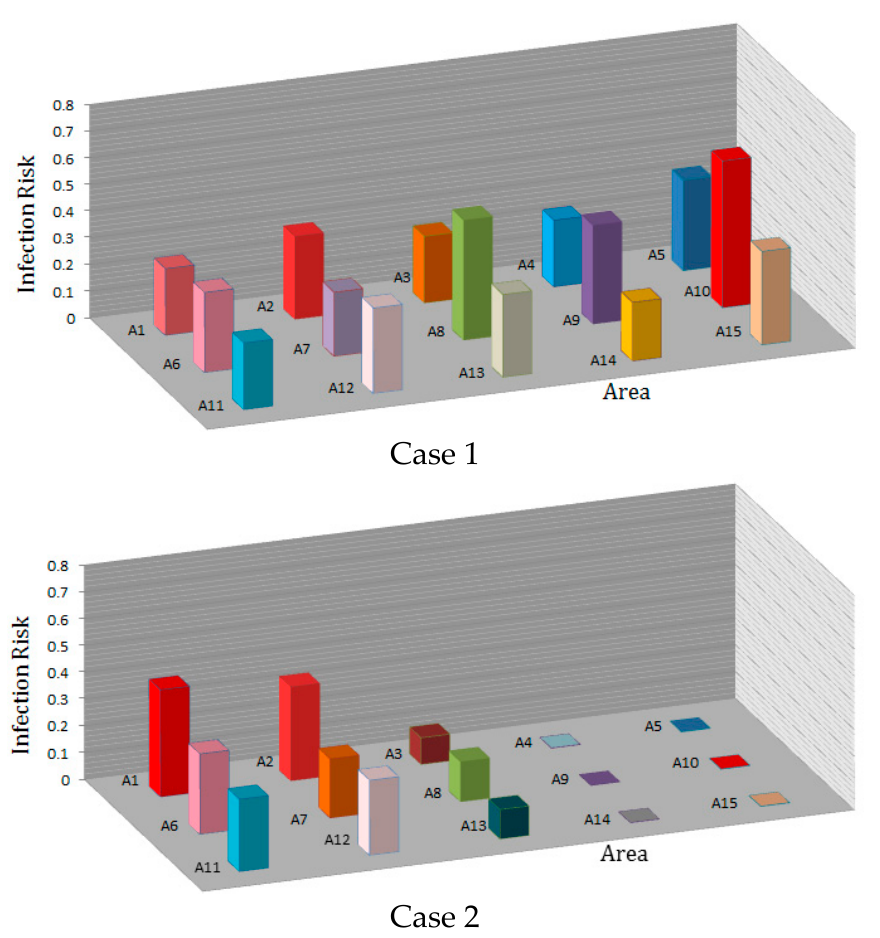
Figure 14. Infection risk of individuals in areas A1 to A15 for Case 1 and Case 2 ventilation systems in the time interval from 0 to 115s when an infected person is coughing in area C.